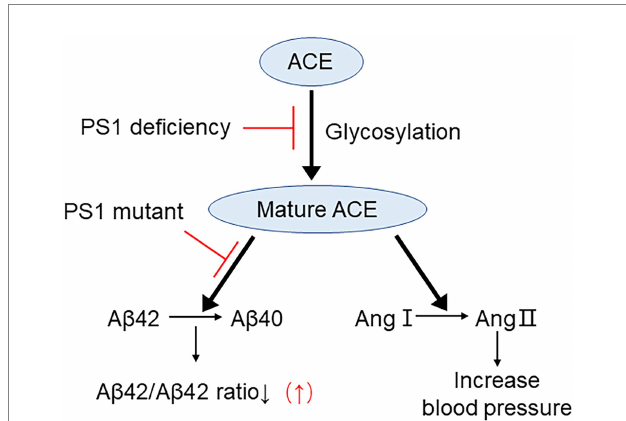
FIGURE 8 Proposed mechanism on PS1 mutant elevating A β 42/40 ratio by impairing ACE maturation. ACE maturation/glycosylation is essential for its A β 42-to-A β 40-and angiotensin-converting activities and for reducing A β 42/40 ratio. PS1 deficiency inhibits ACE maturation and both of these activities. PS1 mutant selectively inhibits A β 42-to-A β 40- converting activity of ACE and elevates A β 42/40 ratio. However, PS1 mutants do not inhibit angiotensin converting activity of